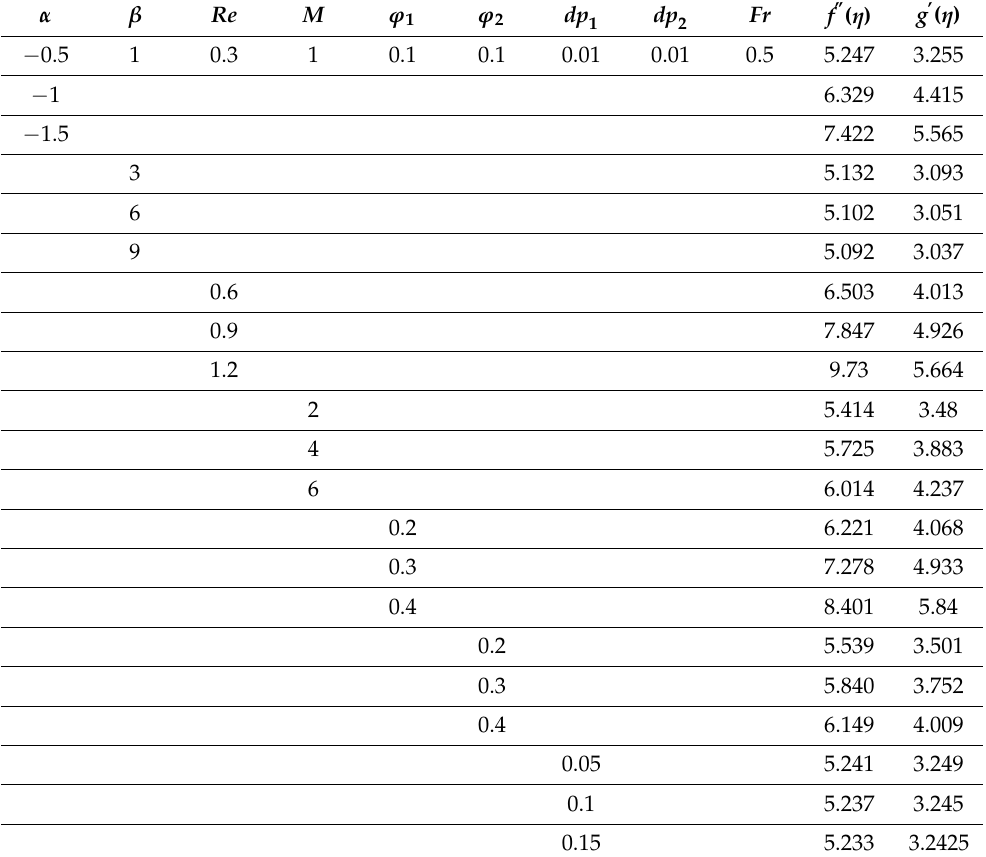
Table 4. Shear stress and tensional stress impact several non-dimensional